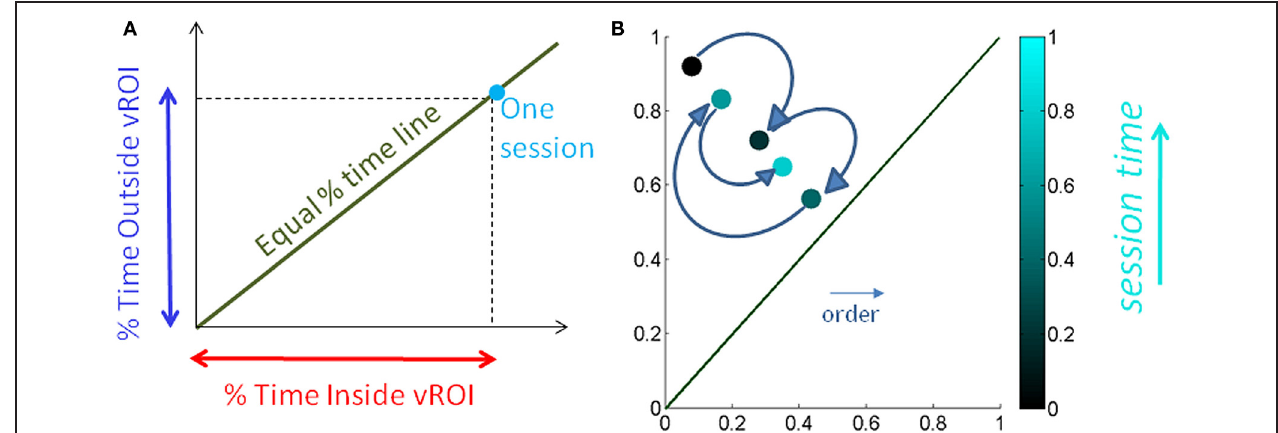
FIGURE 5 | Media preference metric validation for a session. (A) We used the percentage of time spent inside the vRoI vs . percent of time spent outside the vRoI to validate that more time inside the vRoI (lower right area, under the green line denoting equal percentage of time spent inside and outside vRoI) correspond to subject’s stochastic signatures being in more predictive range. (B) We also